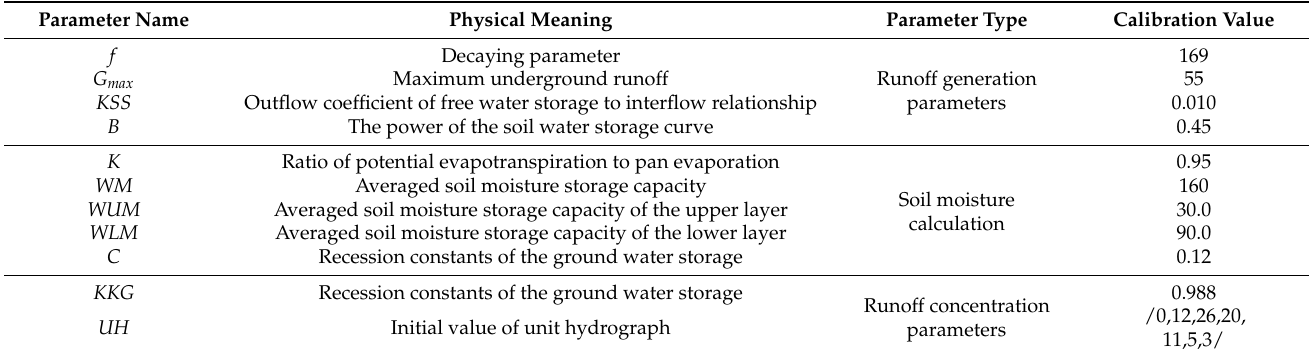
Table 4. The sensitive parameters and their optimal values in the TOPX model.